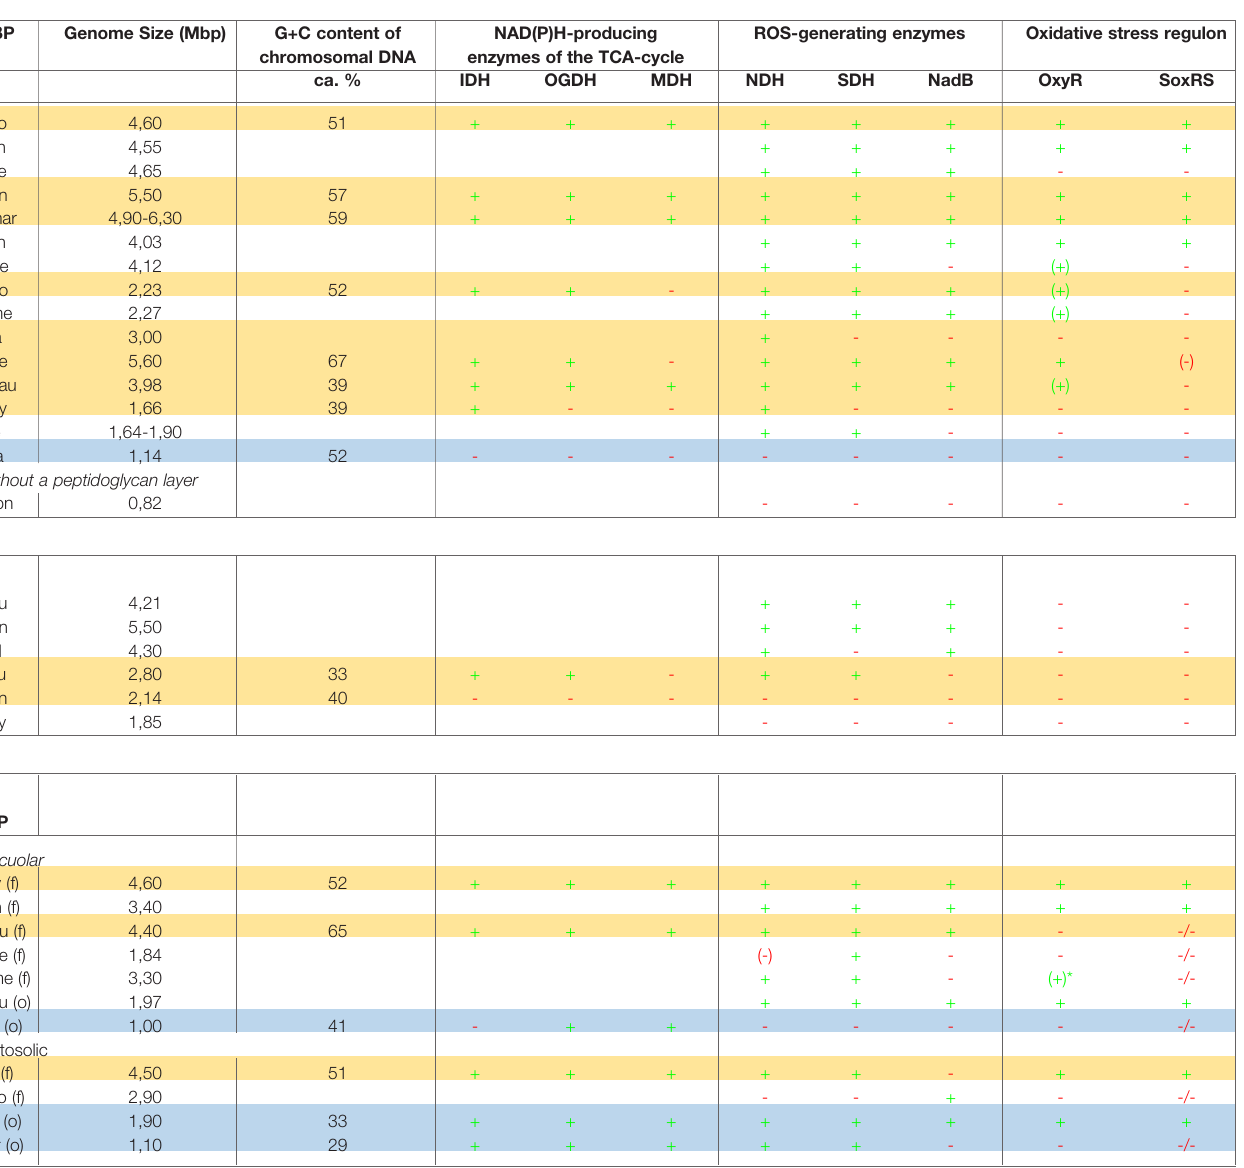
TABLE 1 | Bacterial pathogens and their enzymes and pathways in fl uencing the cellular level of ROS. A EBP Genome Size (Mbp) G+C content of chromosomal